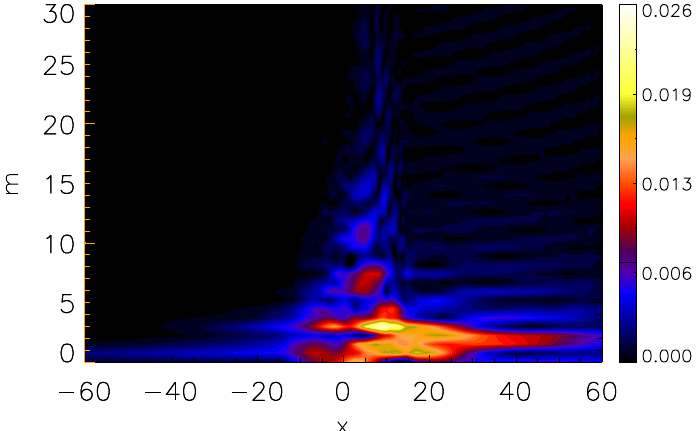
Figure 5. Spectrum of the energy flux density F x along the y direction for each x point in the ( x , k y ) plane at t = 182 for the case V 0 = 7.